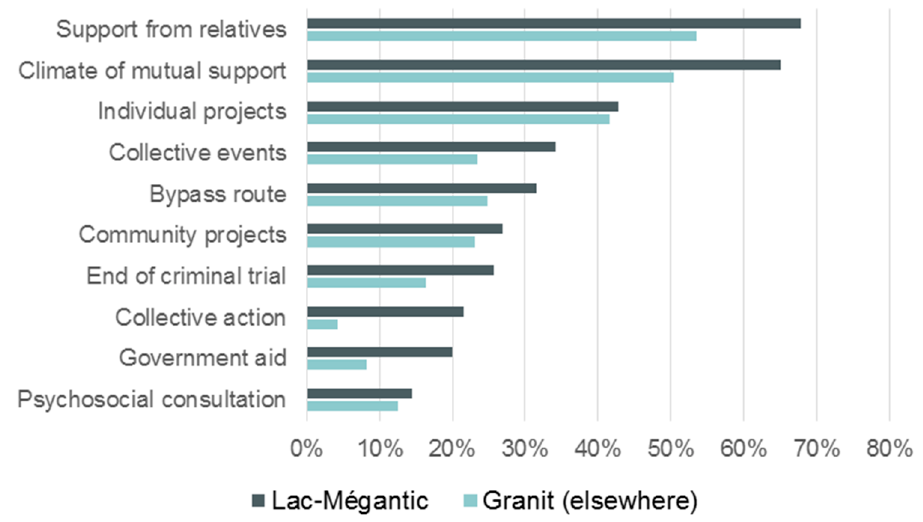
Figure 2. Elements that have significantly improved personal well-being over the past 12 months, “Enqu ê te de sant é populationnelle estrienne” (ESPE) 2018 (Granit area, 800 adults). " Enquête de santé populationnelle estrienne ” (ESPE) 2018 (Granit area, 800 adults). Photovoice